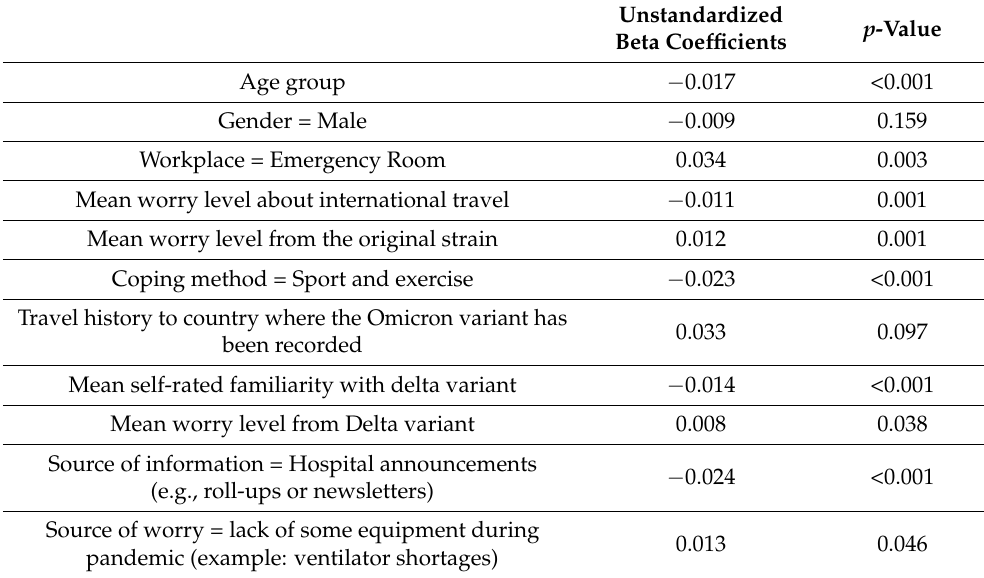
Table 7. Multivariate Linear Regression Analysis of the HCWs’ stress.